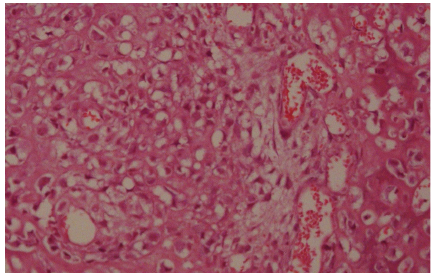
Figure 4: Showing proliferating spindle and oval-shaped mes- enchymal cells with tumor osteoid and tumor bone formation HE ×